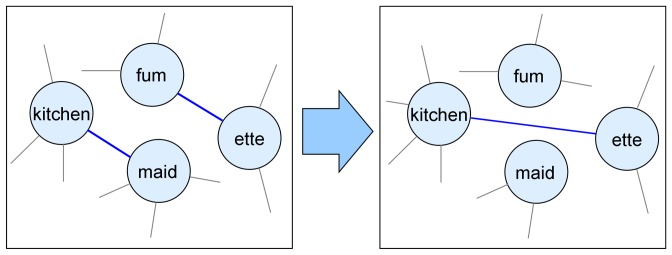
Example for rewiring from English 18th to 20th century.Whereas in the 18th century ‘kitchenwork’ resulted in ‘fumette’, in the 20th century one cooks in a ‘kitchenette’.